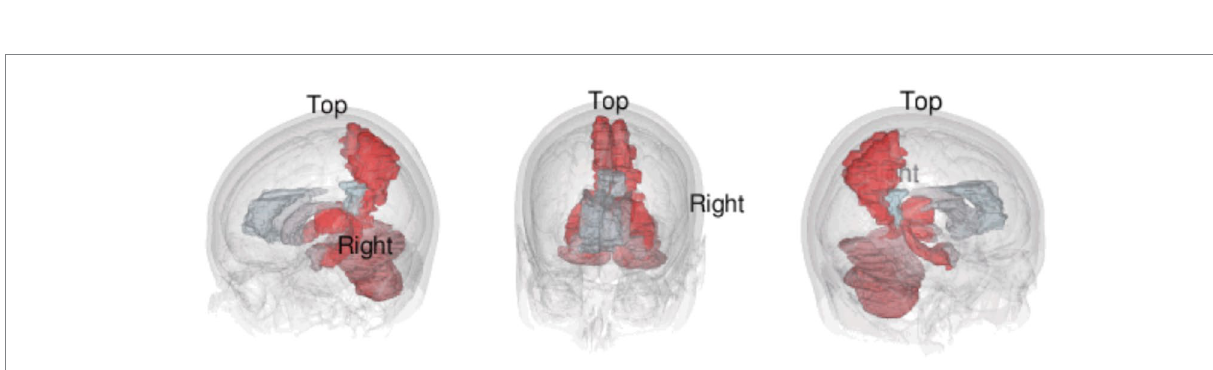
FIGURE 4 Still images of a 3D visualization of the top 10 most frequently mentioned terms from text-mining of the full-texts